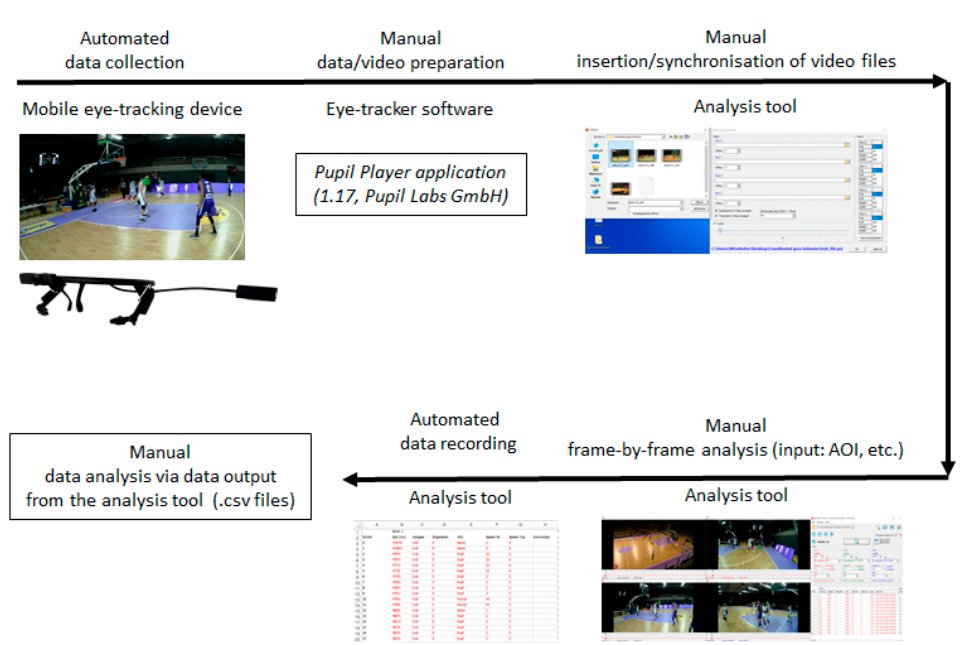
Figure 2. Working process to analyze the gaze coordination of the three referees (modified from [9]). After that, the referees performed their normal pre-game warm-up without the eye- tracking system, until five minutes before the tip-off. Afterwards, the eye-tracking systems were returned to the referees and were calibrated using the Manual Marker Calibration